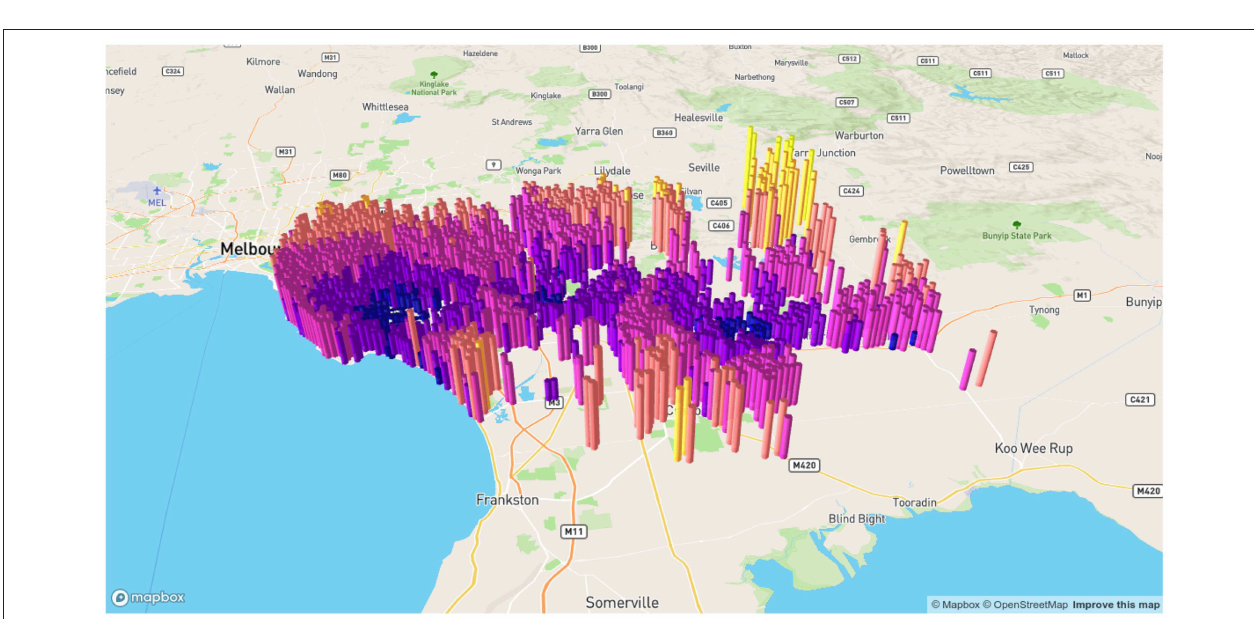
FIGURE 9 | Alternative visualization of distances from random addresses to rehabilitation centeres. Screenshot of interactive visualization created with mapdeck (API key required).